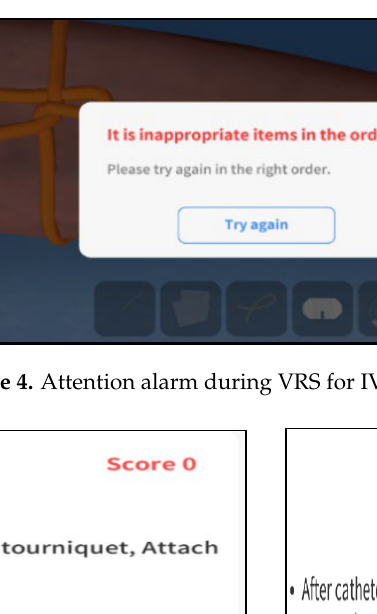
Figure 3. Application of scenario through VRS for IV injection.